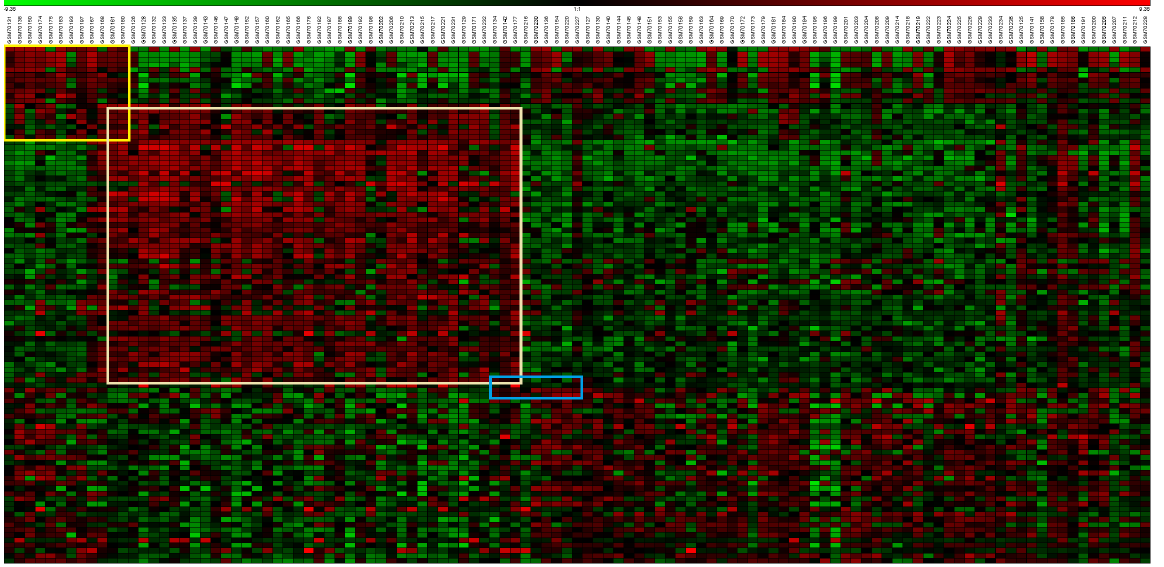
Figure 3. Lung Cancer data: three biclusters are identified, 55 6 40, 18 6 22 and 4 6 10, using top 100 genes. doi:10.1371/journal.pone.0111318.g003 PLOS ONE |